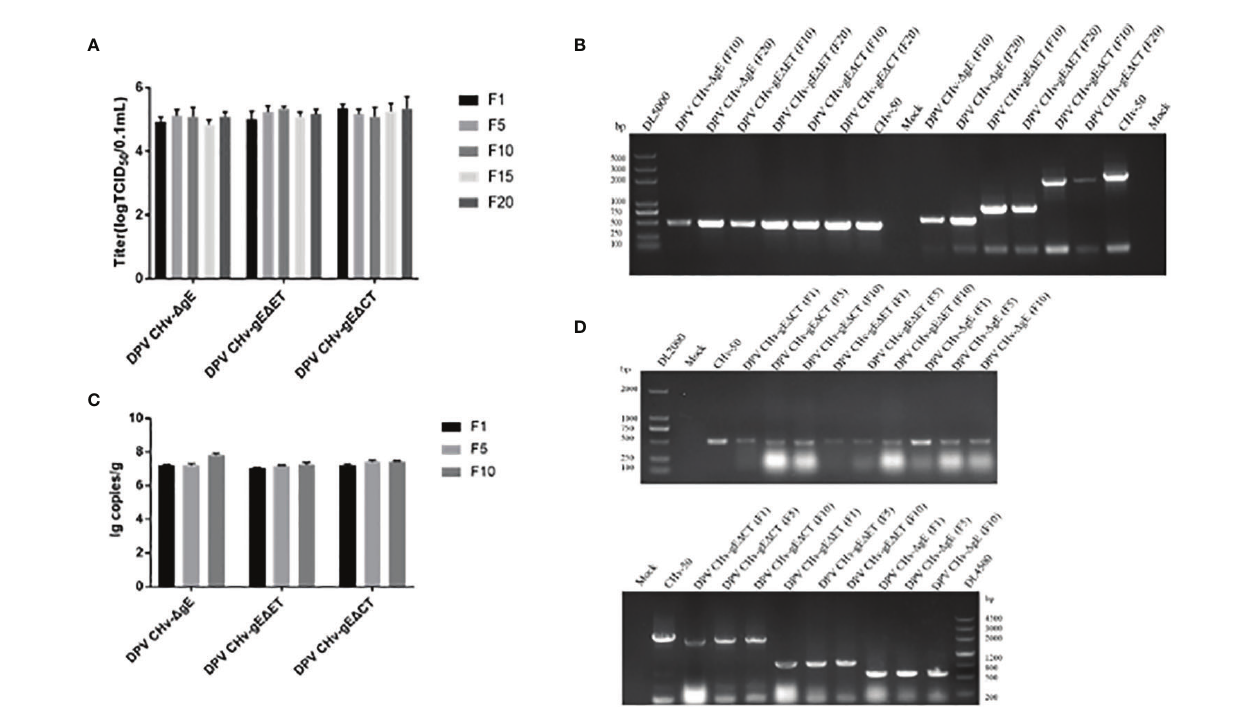
FIGURE 4 | (A) Mutant viruses at passages 1st, 5th, 10th, 15th, and 20th were collected to infect DEFs at a 1 MOI. The cell samples were collected for virus copy number detection, P >0.05. (B) The DNA of the 10th and 20th generation mutant viruses was extracted from DEFs, respectively, and then the primers for UL30 gene identi fi cation and gE gene identi fi cation primers were used for PCR identi fi cation. (C) Mutant viruses at passages 1st, 5th, and 10th were collected to infect ducklings at a 1 MOI. After 7 days of infection, the ducklings were slaughtered, 1 g of liver tissue was taken out, and the viral genome in the liver tissue was extracted for copy number determination, P >0.05. (D) DNAs of the 1st, 5th, and 10th generation mutant viruses were extracted from liver tissue, respectively, and PCR identi fi cation was performed with UL30 gene identi fi cation primers and gE gene identi fi cation primers,